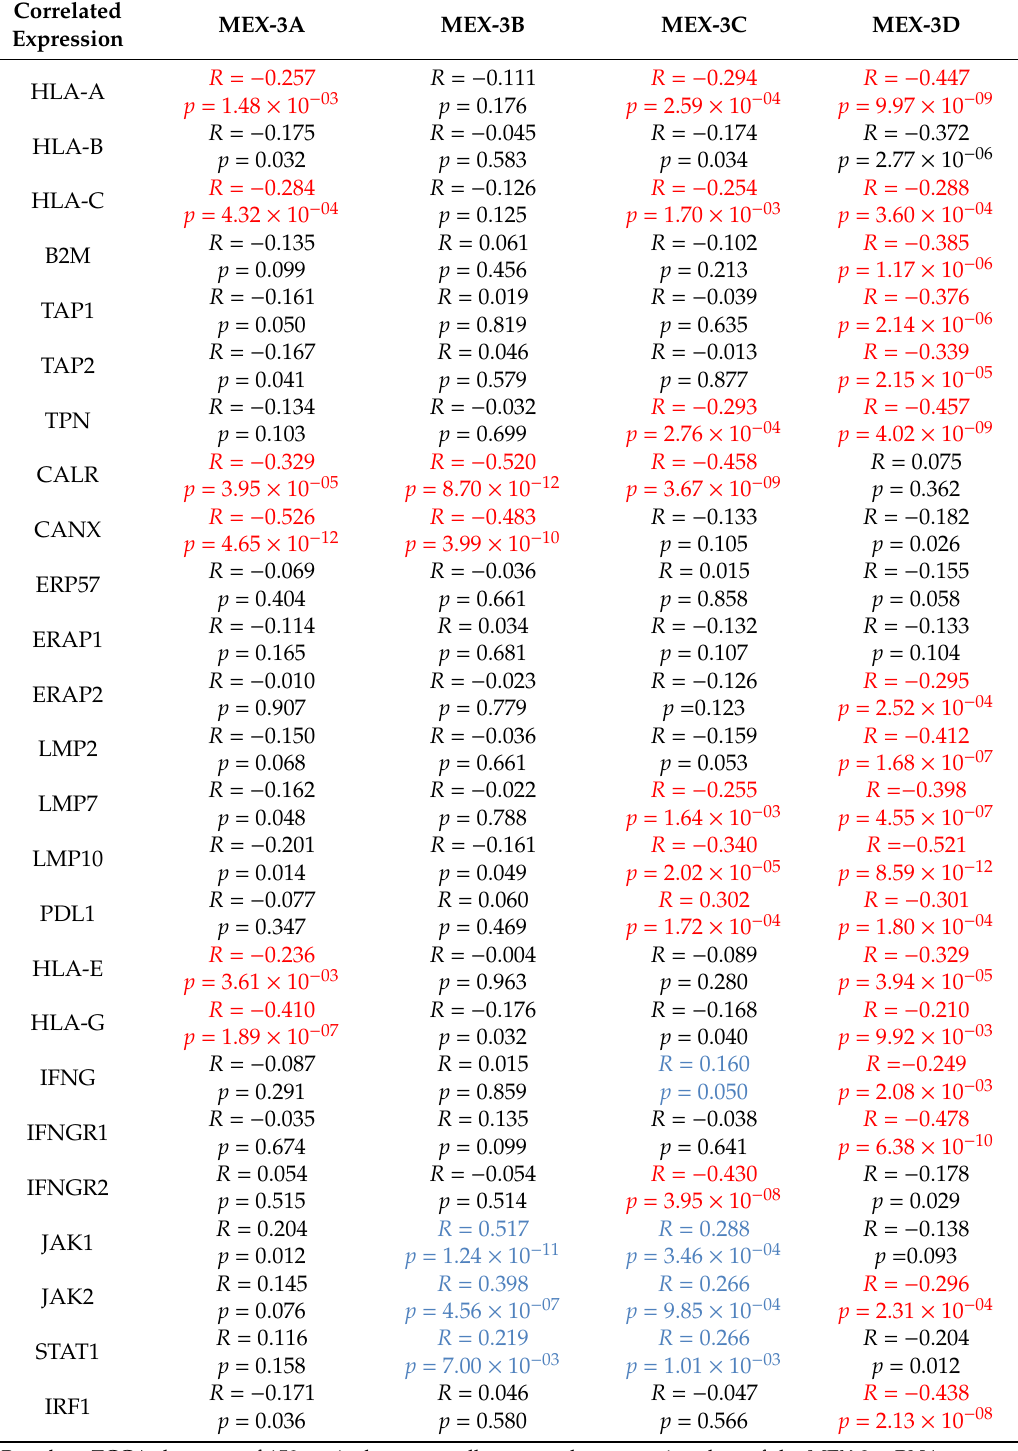
Table 3. Correlation of the MEX-3A-D expression to the expression of selected immune modulatory genes.